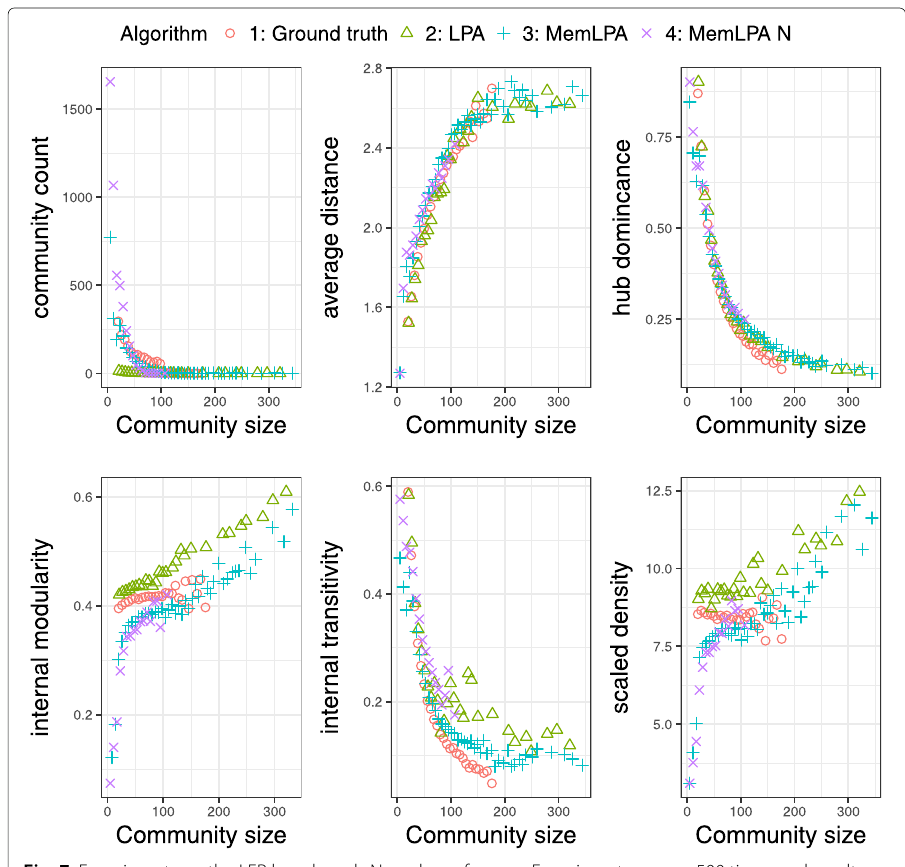
Fig. 7 Experiments on the LFR benchmark. N: node preference. Experiments are run 500 times and results averaged on communities having same size. The KS distance between the ground truth and communities found is shown in the table